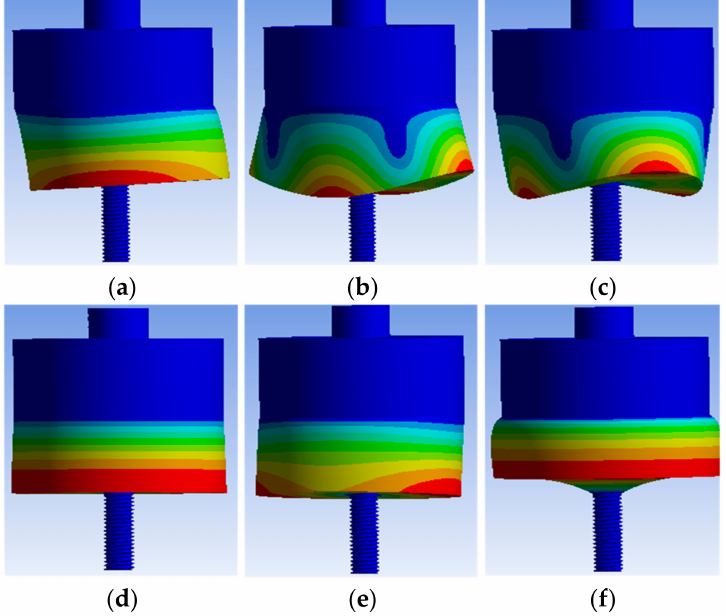
Figure 5. Vibration models, ( a ) one modal ( b ) two modal ( c ) three modal ( d ) four modal ( e ) five modal ( f ) six modal.